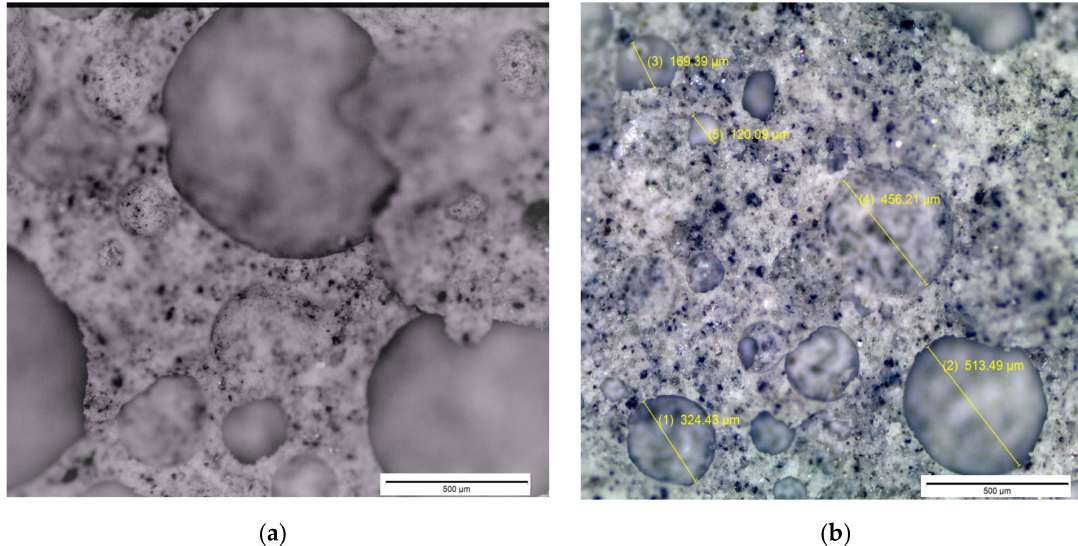
Figure 12. Optical microscope images of sections of aerated slurries with different dosages of the